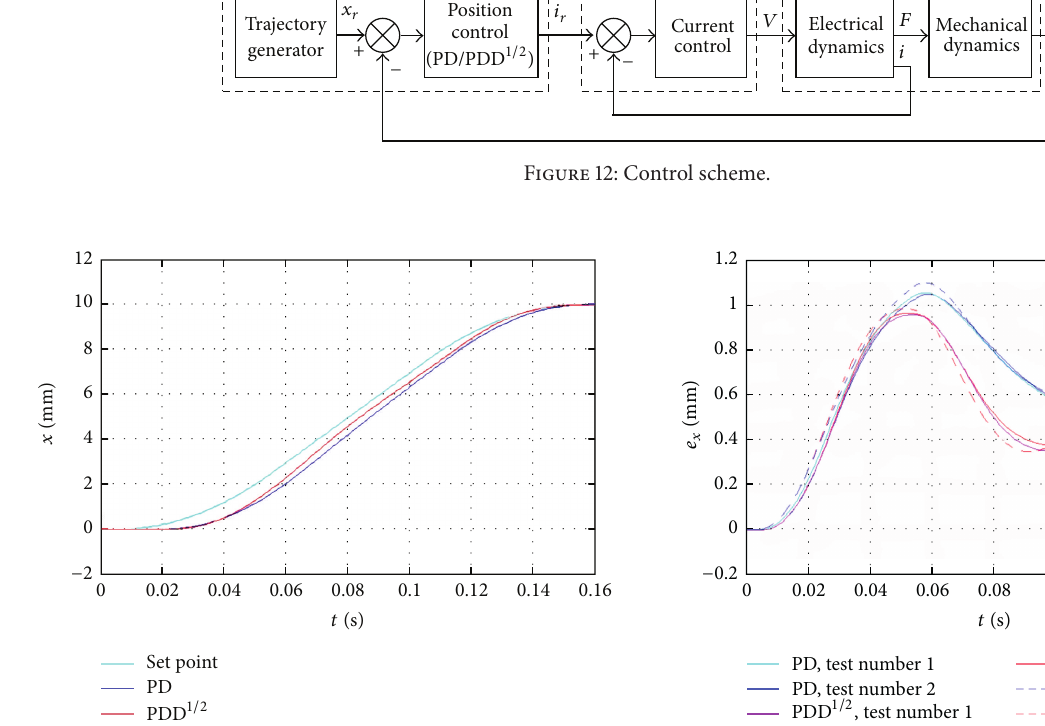
Figure 13: PD-PDD 1/2 comparison: displacement in case of set point with trapezoidal speed law (PD: 𝜁 = 1 ; PDD 1/2 : 𝜁 = 0.45, and 𝜓 = 1.4266 ).